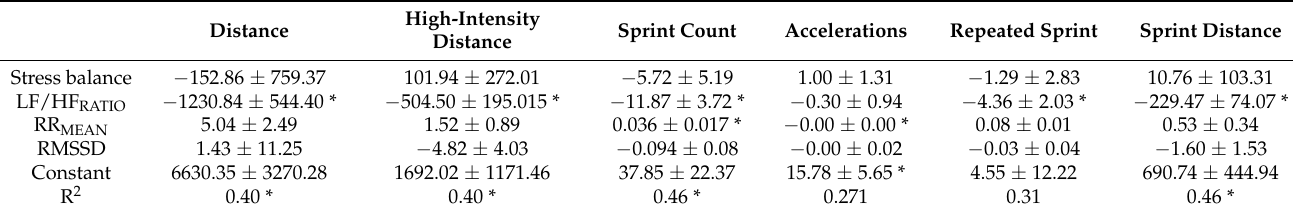
Table 2. Regression analysis of the influence that automatic cardiac responses have during physical demands in young elite soccer players. High-Intensity Distance Sprint Count Accelerations Repeated Sprint Sprint Distance